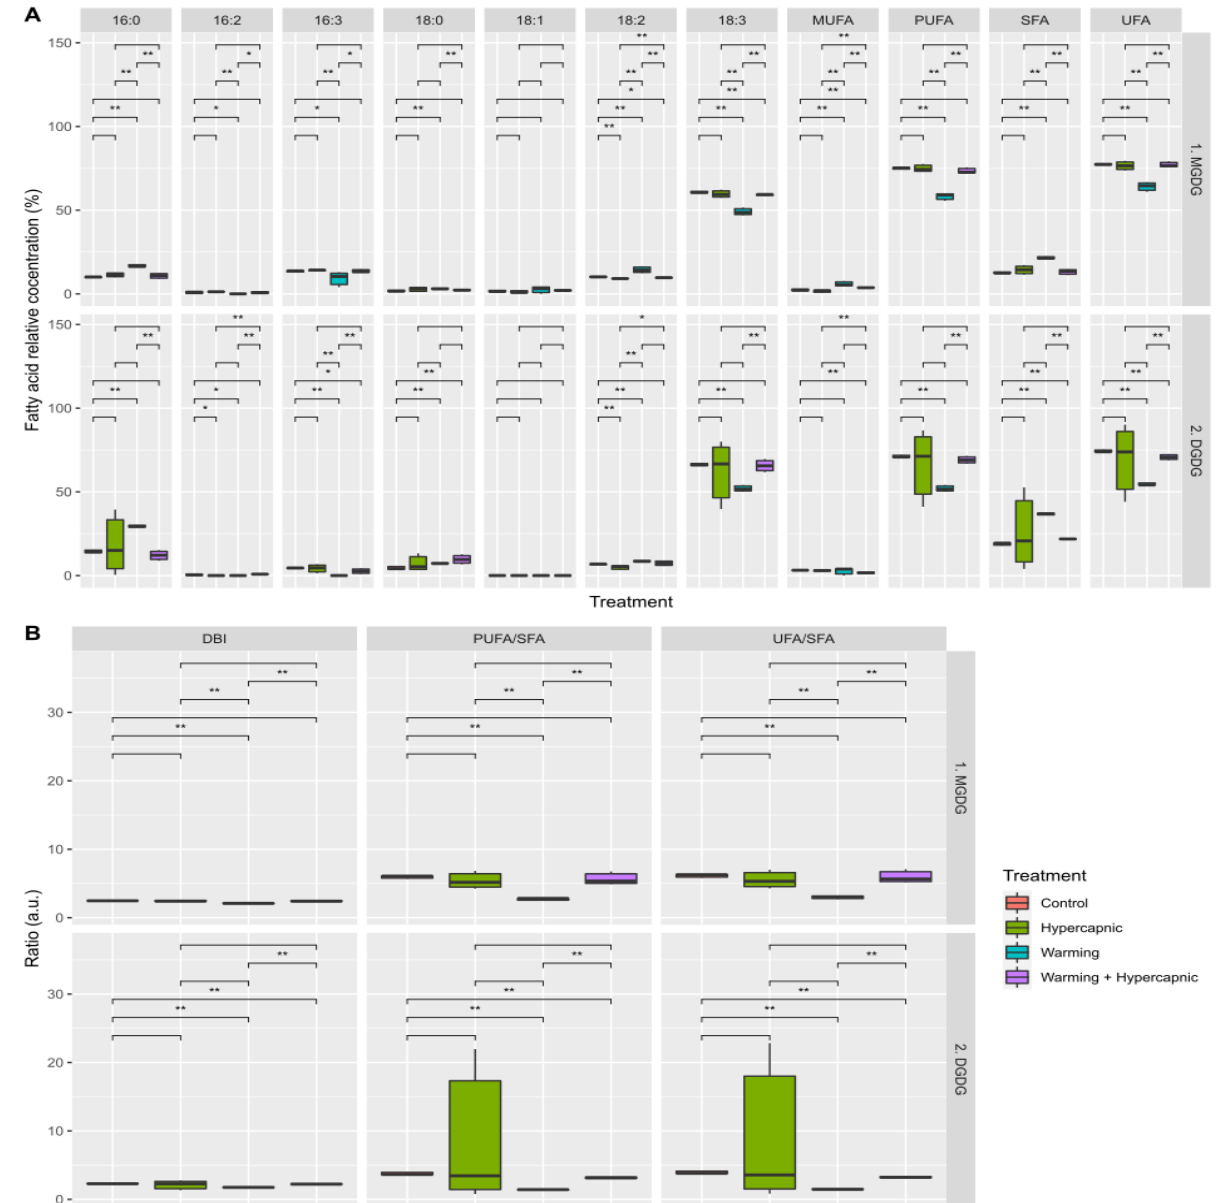
Figure 5. Zostera noltii leaf digalactosyldiacylglycerol (DGDG) and monogalactosyldiacylglycerol (MGDG) fatty acid composition and classes (monounsaturated fatty acids (MUFAs), polyunsaturated fatty acids (PUFAs), saturated fatty acids (SFAs), and unsaturated fatty acids (UFAs)) ( A ) and fatty acid indexes and ratios (double-bond index, DBI; polyunsaturated to